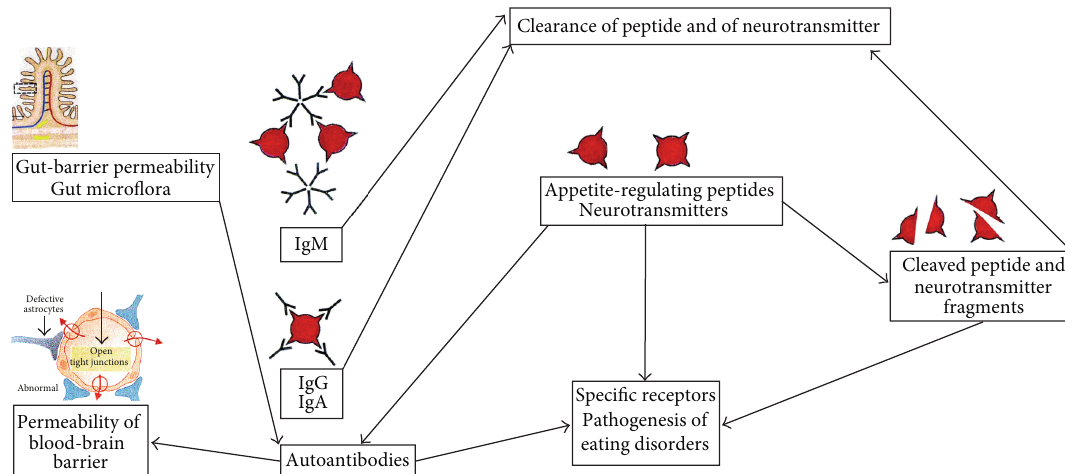
Figure 2: The role of up- or downregulated neutralizing autoantibodies (immunoglobulin (Ig) M, IgG, and IgA classes, and changes of their affinity) directed against appetite-regulating neuropeptides and peptides and neurotransmitters (dopamine, dopamine-beta-hydroxylase, and serotonin) in neuropeptidergic transmission and the pathogenesis of eating disorders. Producing excess of free fatty acids (FFA) and ketones to increase the permeability of the blood-brain barrier and to enter the cerebral matter in AN and BN [103]. Starvation, stress, catecholamines,microbialantigens,poststreptococcalautoimmuneprocess(PANDAS),andproinflammatorycytokinesdecreaseblood-brain barrier integrity in parallel with decreased levels of the tight junction protein, occludin [104]. Also autoantibodies against appetite-regulating peptides and neurotransmitters may disrupt the blood-brain barrier and the gut-barrier permeability in AN and BN [268]. Furthermore, gut-related antigens including gut microflora may influence production of specific autoantibodies (IgA class) against appetite-regulating hormones [47]. Indeed, starvation decreases the gut-barrier permeability in AN [102] and may decrease ghrelin autoantibodies (IgM, IgG, and IgA classes) production. However, realimentation-induced changes in the gut-barrier permeability and new antigenic stimulation during refeeding were accompanied by an increase of acylated ghrelin autoantibodies (IgM class) in AN